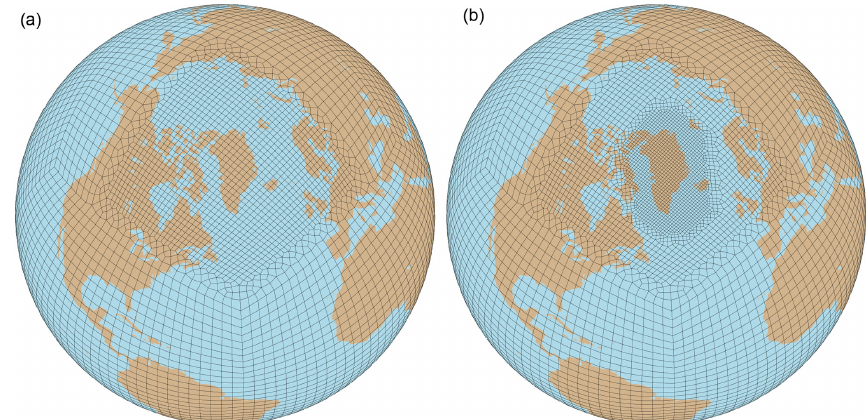
Figure 1. Computational domains of experiments VR-CESM55 (a) and VR-CESM28 (b) . Each spectral element visible here contains an additional 3-by-3 grid of points, the exact positions of which are determined by the spectral element method (Zarzycki and Jablonowski,